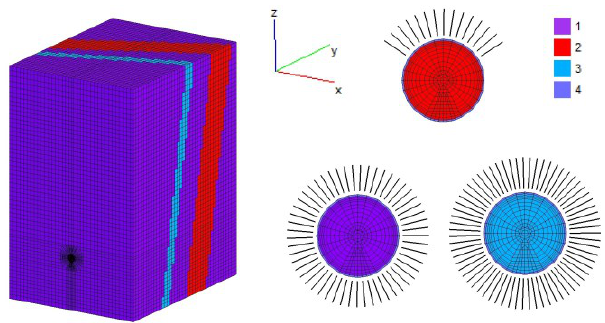
Figure 4. Finite element model of tunnel and analysis model of support.